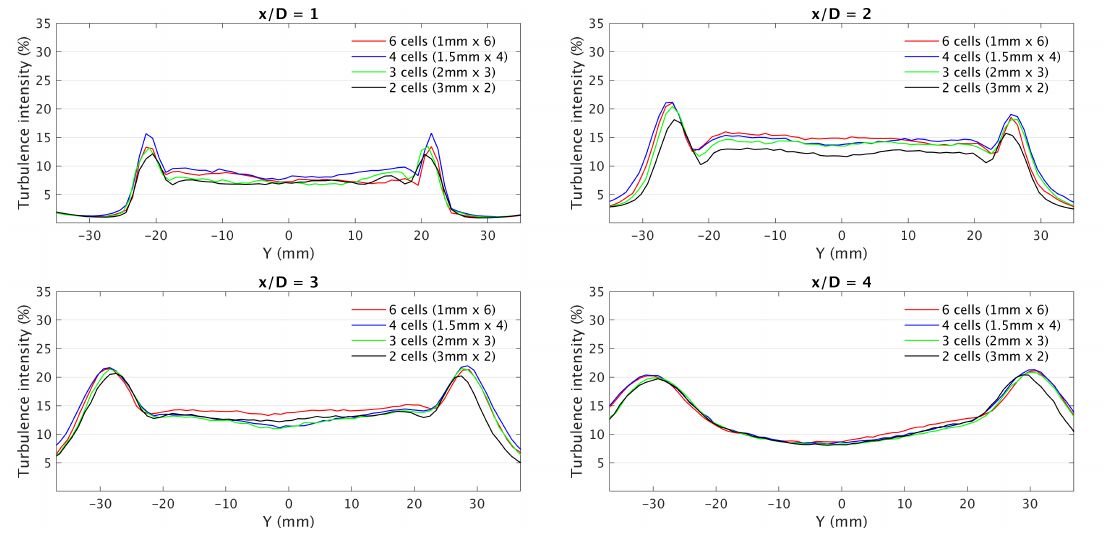
Figure 18. Turbulence intensity graph for cylinders 14–17.